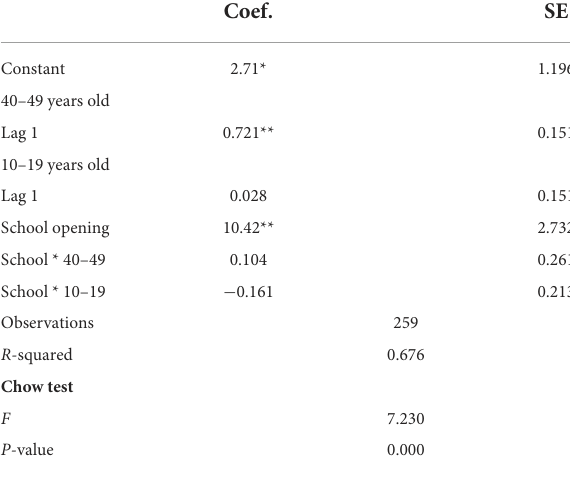
TABLE 5 Chow test of school reopening.